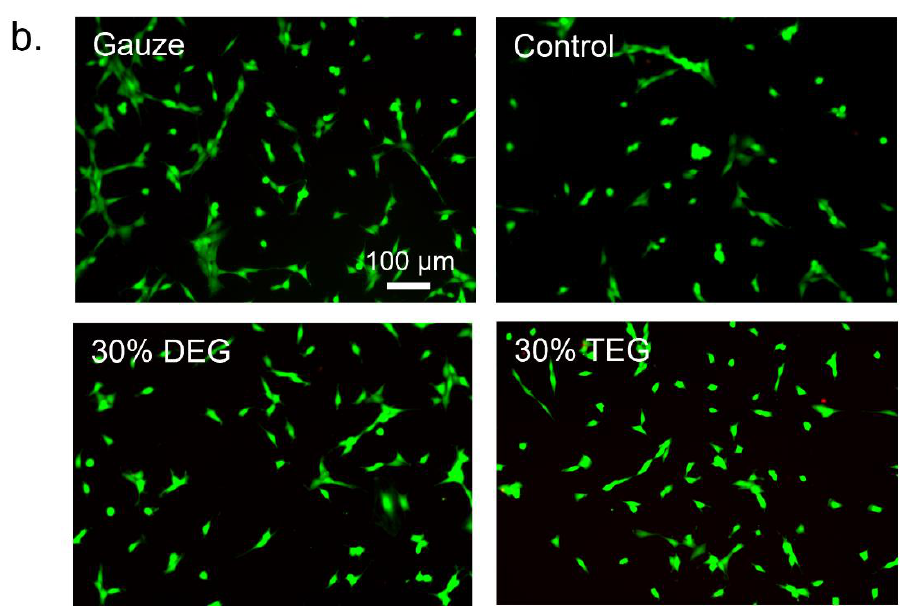
Figure 7. Cytocompatibility of SMP foams. ( a ) 3T3 mouse fibroblast viability over 24 h (n = 3). ( b ) Representative live/dead cell images were used to calculate viability. Live cells were stained green and dead cells were stained red. Scale bar applies to all images.